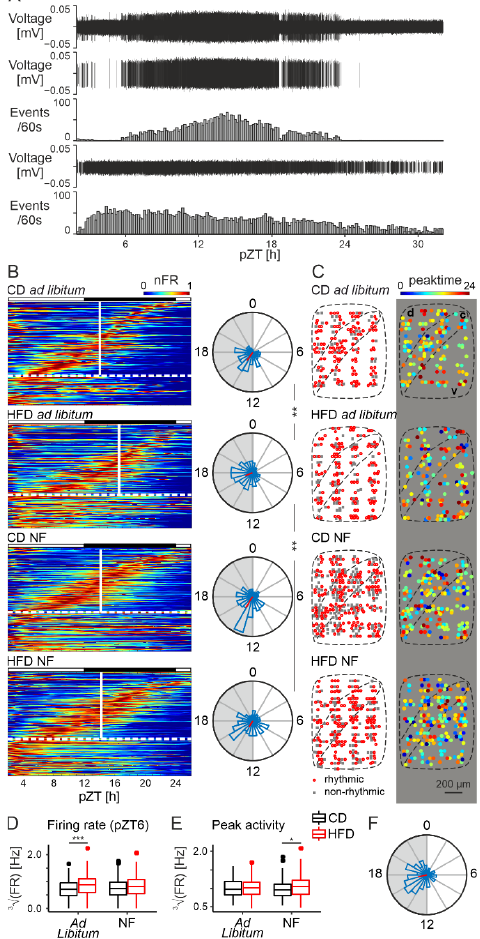
Figure 4. HFD delays circadian patterning of neuronal activity of the DMH. ( A ). Representative recording of a raw signal (top trace), followed by 2 spike-sorted cells (one rhythmic and one non- rhythmic), for which extracted action potentials and their frequency (extrapolated activity over 10 min) are presented. ( B ). (left) Heatmaps presenting the activity of all recorded neurons across the 24 h of recording. Cells with a single activity peak are called rhythmic and sorted by peak time. They are followed by the non-rhythmic cells, from which they are separated with a horizontal dotted line. Average peak value for each group is represented by white, vertical lines. Black and white rectangles above each heatmap reflect projected light – dark phases. (right) Rose petal diagrams (circular histograms of peak times) for each group (bin width: 1 h). The length of the vector (in red) codes the strength of the clustering. Asterisks present the results of the Watson-Williams test: ** p < 0.01. Shaded semi-circles represent the dark phase. CD — control diet, HFD — high-fat diet, NF — night feeding, nFR — normalized firing rate. ( C ). Heatmaps presenting spatial distribution of the rhythmic cells (left) and peak time values (right) throughout the structure. d — dorsal part of the DMH, c — compact part of the DMH, v — ventral part of the DMH. ( D ). Comparison of the firing rate at projected Zeitgeber time 6 (pZT6; Ad libitum: F1,388 = 11.338, p = 0.00084; NF: F1,5 = 2.98, p = 0.15). *** p < 0.001. FR — firing rate. ( E ). Comparison of the firing rate at the time of peak activity (Ad libitum: F1,4 = 0.019, p = 0.9; NF: F1,352 = 5.86, p = 0.016). * p < 0.05. Box-and-whisker plots present the median value, the interquartile range (IQR; box) and the minimum-to-maximum range of values, not exceeding 1.5 * IQR (whiskers). Data points outside this range are plotted individually as outliers. ( F ). Rose petal diagram (circular histogram of peaks) for an experiment starting at pZT12 (bin width: 1 h). The length of the vector (in red) codes the strength of the clustering. Shaded semi-circle represents the dark